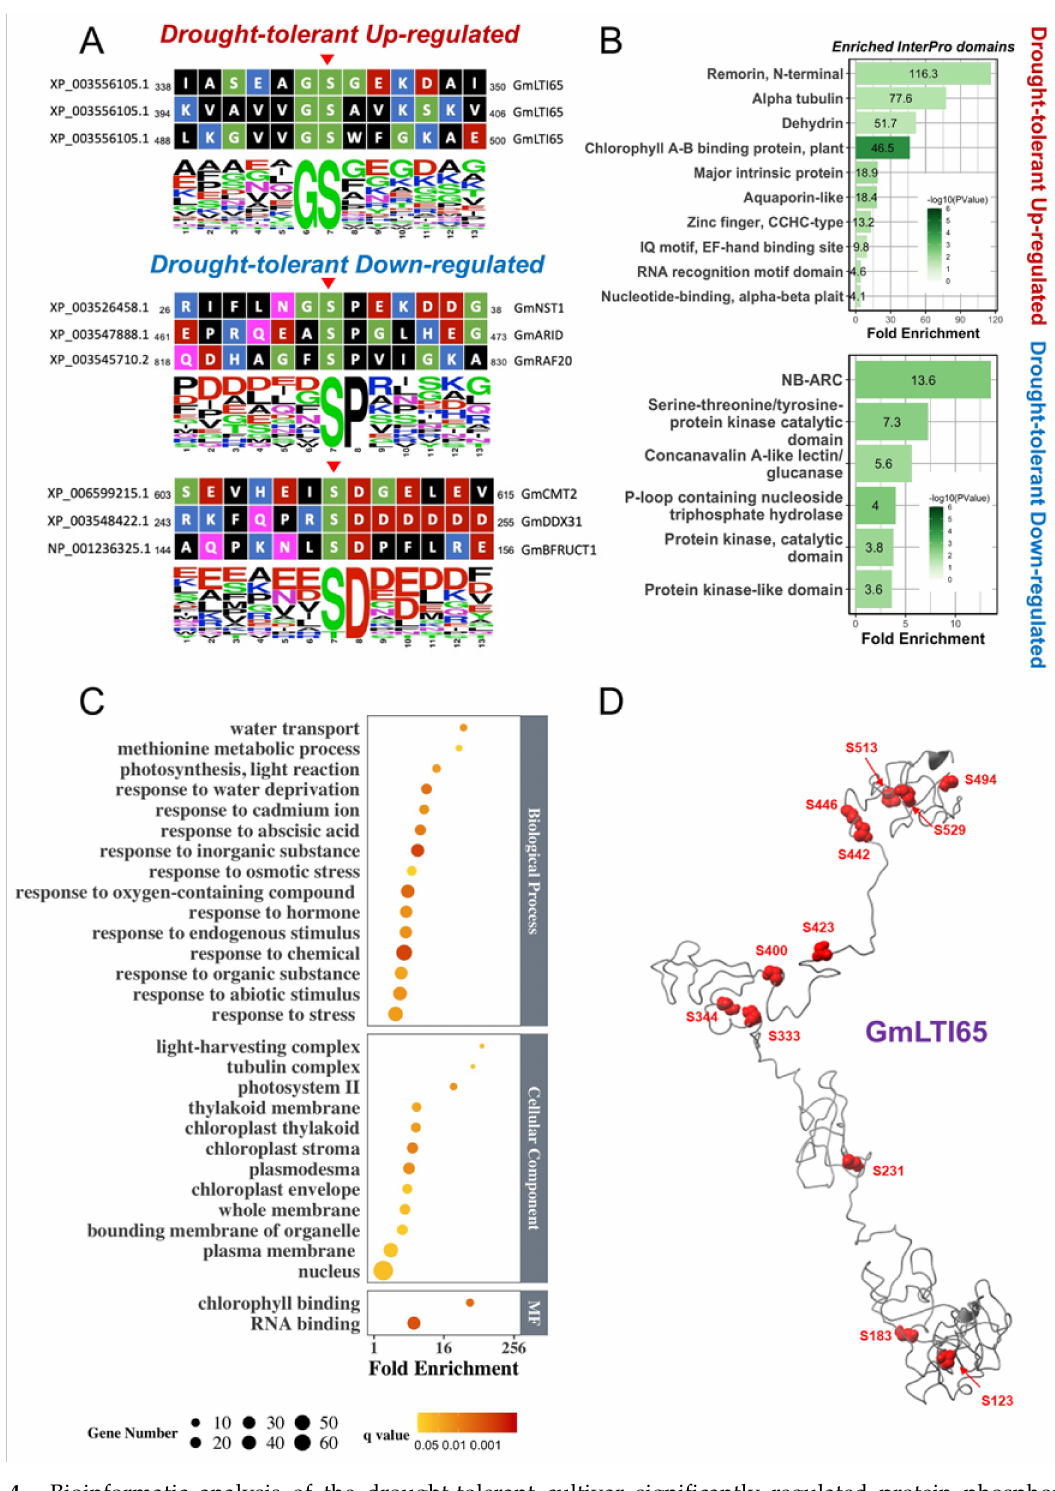
Figure 4. Bioinformatic analysis of the drought-tolerant cultivar significantly regulated protein phosphorylation. ( A ) Phosphosite motifs constructed using the Motif-X and Motif-All [64,65] from the highly selected and the significantly regulated phosphopeptide groups (Supplementary Table S6a). ( B ) The InterPro domains enriched from significantly up- (upper panel) and downregulated (lower panel) leading phosphoproteins (Supplementary Table S6a). The number in each bar indicates the fold enrichment (observed vs. expected). The color in each bar indicates the negative logarithm of p value. ( C ) GO enrichment analysis of the significantly regulated phosphoproteins (Supplementary Table S6a). The biological processes, cellular component and molecular function of significance (FDR ≤ 0.05) are shown. The color of dot indicates the significance of the enrichment from 0.05 (yellow) to 0.00000001 (deep red). The size of the dot represents the number